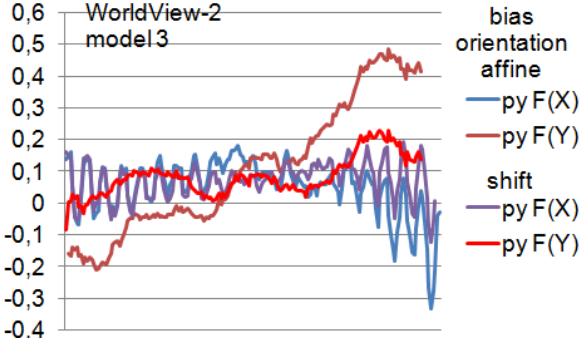
Figure 1. Systematic y-parallaxes of WorldView-2 (0.5m GSD) height model 2 based on RPC-orientation with bias correction by affine transformation and by shift [m]